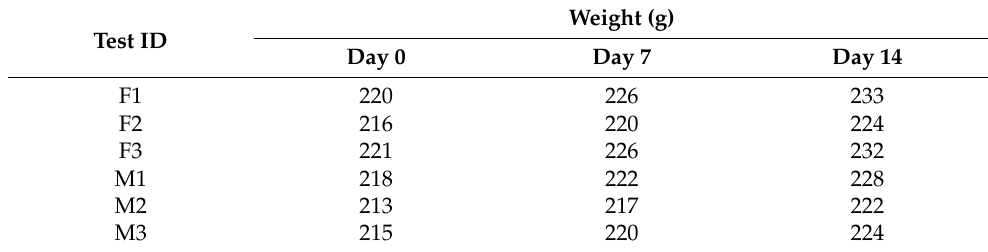
Table 11. Weight of animals after acute inhalation toxicity